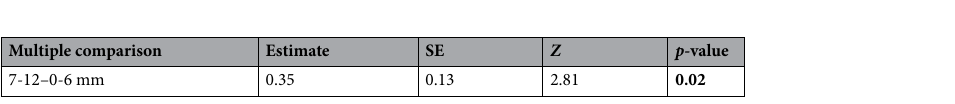
Table 5. Multiple comparison between pupation depth of the hatched flies. Test: Tukey Honest Significant Difference. Significant values are in bold.